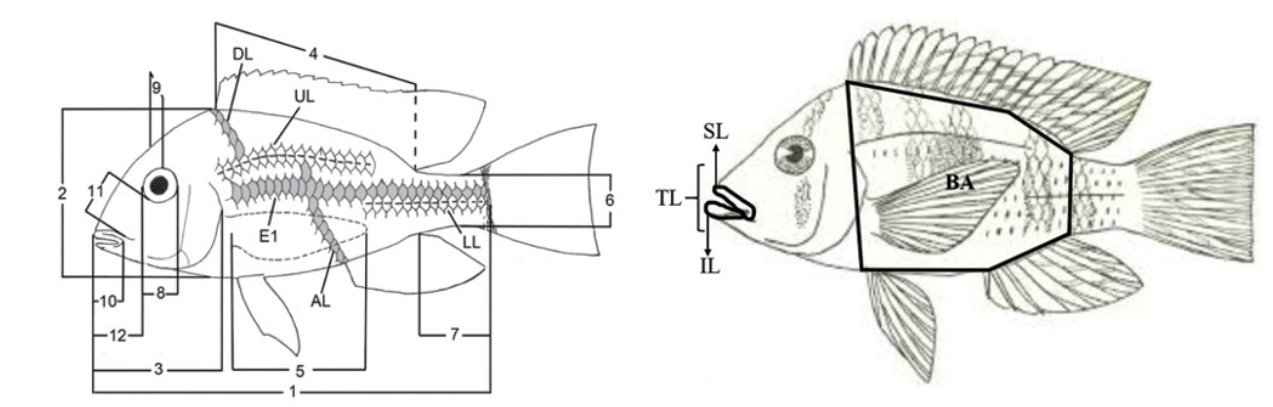
FIGURE 2 | Measurements and counts applied to specimens used in the present study, according to Malabarba et al . (2015). 1: Standard length; 2: Body depth; 3: Head length; 4: Dorsal-fin base length; 5: Pectoral-fin length; 6: Caudal peduncle depth; 7: Caudal peduncle length; 8: Eye diameter; 9: Interorbital width; 10: Upper jaw length; 11: Pre-orbital length; 12: Snout length; E1: Scales in a longitudinal series; DL: Scales between the origin of the dorsal fin and the upper part of the lateral line; UL: Scales in the upper portion of the lateral line; LL: Scales in the lower portion of the lateral line; AL: Scales between the origin of the anal fin and the top of the lateral line. Measurements of the lip area applied to the specimens used in the present study, modified by Buckup, Reis, (1985). SL: upper lip area; IL: lower lip area; TL: total lip area; BA: body